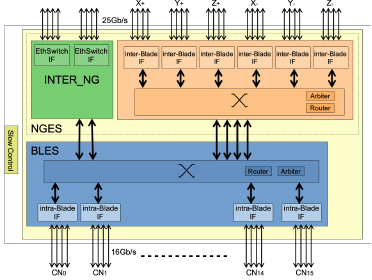
Figure 6. EuroEXA Custom Switch block diagram option 1.